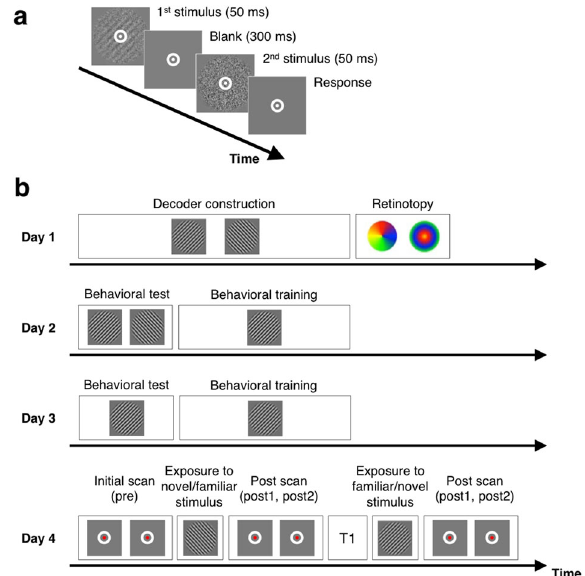
Fig. 1 Task and experimental procedure. a Subjects performed a 2IFC orientation detection task. Two stimuli, a target consisting of a Gabor patch embedded in noise and a non-target consisting of pure noise, were presented in random order. Subjects indicated which interval contained the target. b The experiment consisted of 4 days. On day 1, we collected decoder construction and retinotopic mapping scans. On days 2 and 3, subjects were familiarized with one Gabor orientation (either 45° and 135°, counterbalanced between subjects) via extensive training on the task using that orientation (several subjects had additional prior training with that orientation; see Methods). Finally, on the critical day 4, we fi rst recorded subjects ’ brain activity patterns before subjects saw any stimuli (two 5-minute scans; combined into a single “ pre ” score). We then gave subjects a brief exposure to the task with either the novel or the familiar orientation and then collected the spontaneous brain activity pattern for two more 5-minute scans. After a brief break, during which we collected a T1 scan, we repeated the procedure for the other (familiar or novel) stimulus. The order of exposure to the novel and familiar orientation was counterbalanced across